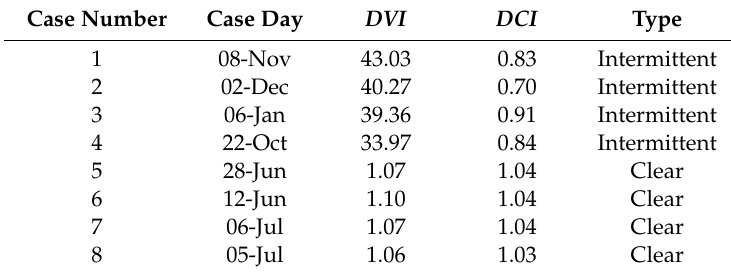
Table 1. Description of cases selected in